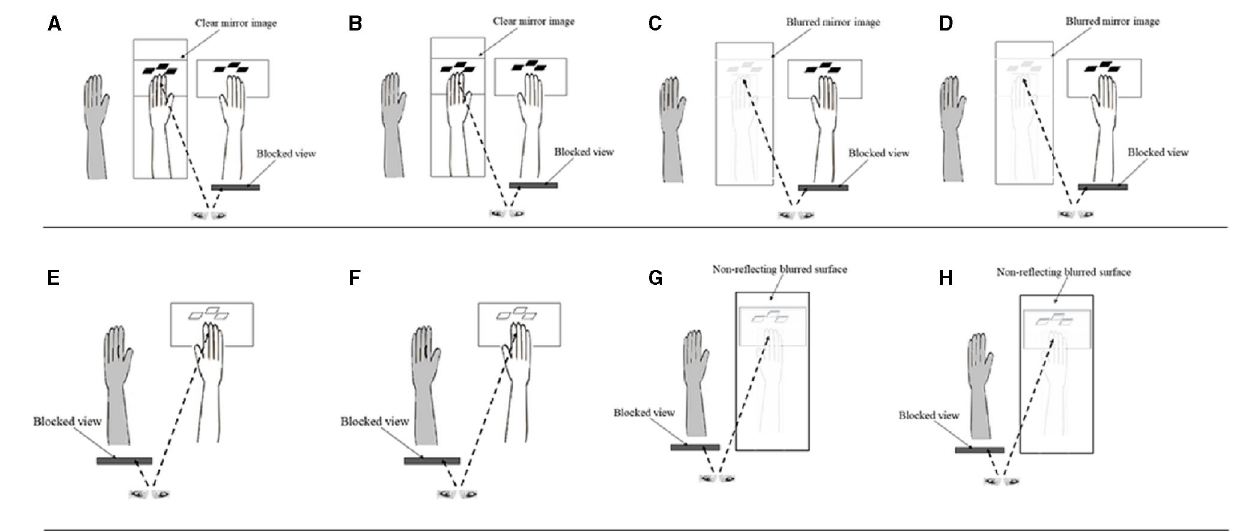
FIGURE 1 | Schematic diagrams of the different conditions in the study. (A) Mirror Clear + Simple; (B) Mirror Clear + Complex; (C) Mirror Blurred + Simple; (D) Mirror Blurred + Complex; (E) Direct Clear + Simple; (F) Direct Clear + Complex; (G) Direct Blurred + Simple; and (H) Direct Blurred + Complex (Control conditions: E–H ). Ash colored limb depicts the static affected or left limb (among healthy participants), hidden behind the mirror (in panels A–D